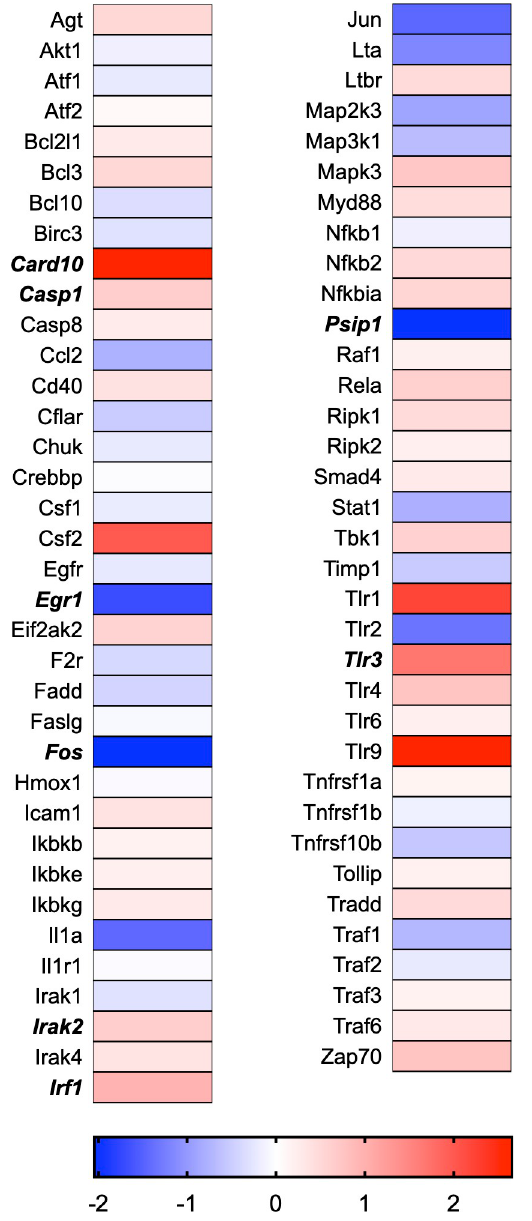
Fig 16. NF- κ B signaling heat map. Bold text indicates significantly altered gene